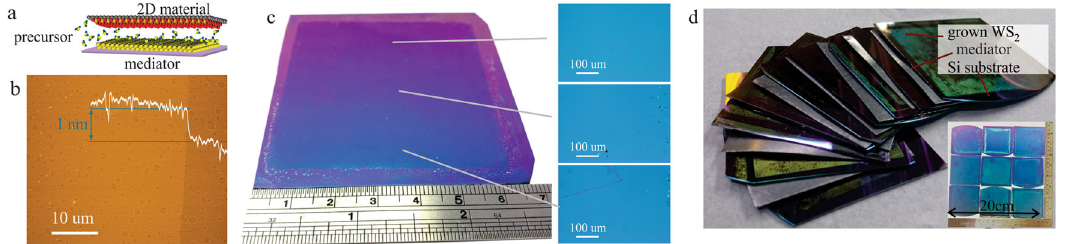
Fig. 1 Scale of mediator-assisted CVD. a Schematic of mediator-assisted growth. b AFM image of mediator-assisted WS 2 growth result with overlaid cross-sectional height. c Photograph of large-scale WS 2 sample with optical micrographs taken at different locations indicating uniformity. d Photograph of WS 2 synthesized within a stack during a single growth batch, (inset) photograph of attained growth area from 3 ” reactor